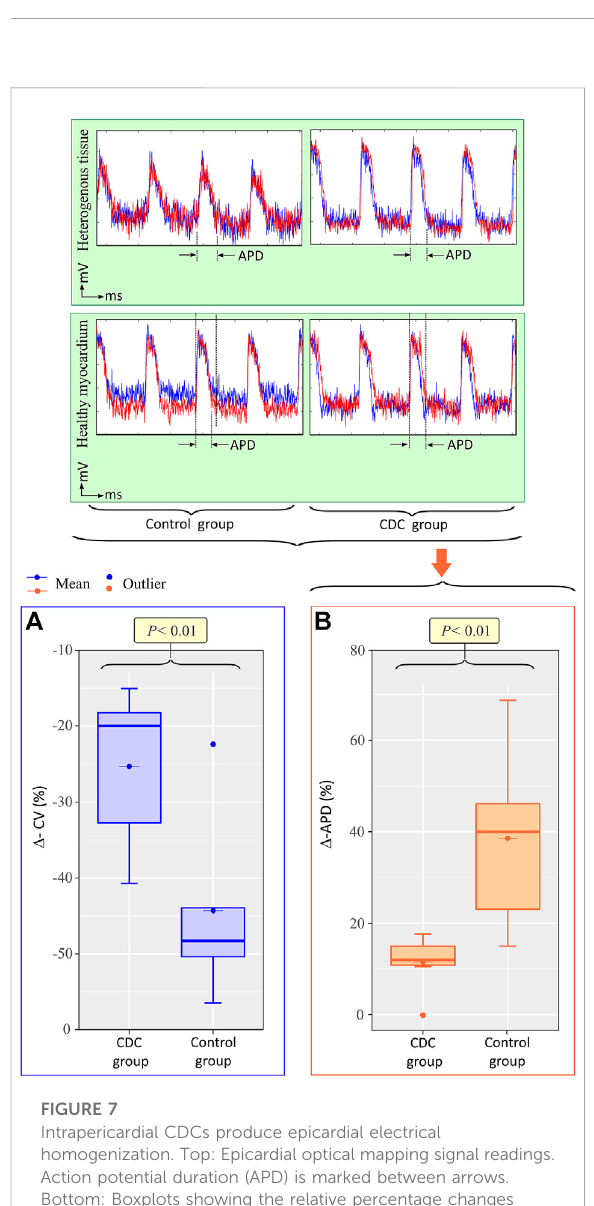
FIGURE 7 Intrapericardial CDCs produce epicardial electrical homogenization. Top: Epicardial optical mapping signal readings. Action potential duration (APD) is marked between arrows. Bottom: Boxplots showing the relative percentage changes in CV (A) and APD (B) between heterogeneous tissue and healthy myocardium. Abbrv: APD = action potential duration, CDC = cardiosphere-derived cells, Δ APD = percentage change in action potentialbetweenheterogeneoustissueandhealthymyocardium, Δ CV = percentage change in CV between heterogeneous tissue and healthy